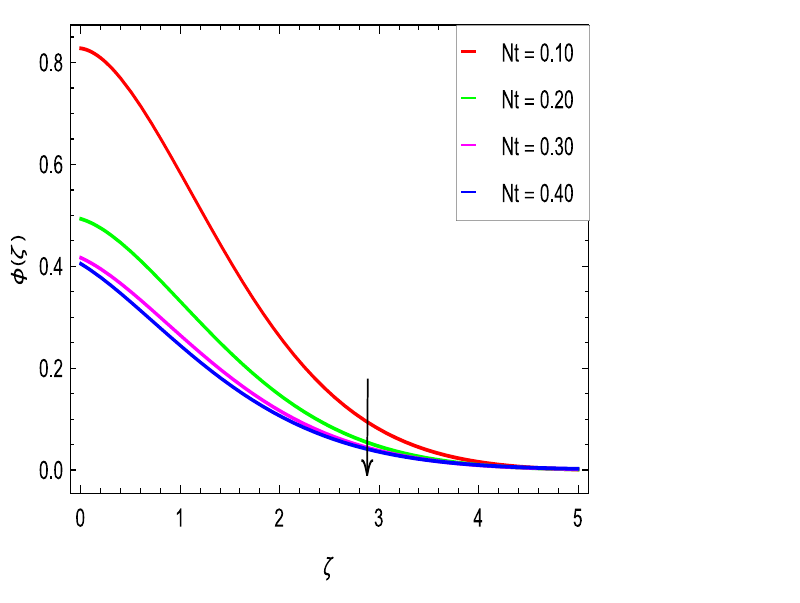
Figure 19. φ(ζ) in terms of Nt